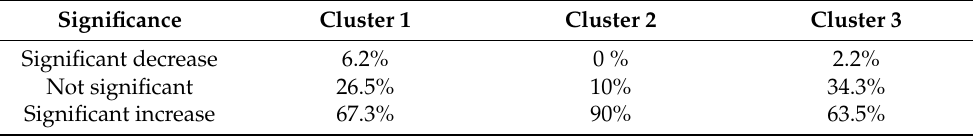
Table 4. Percentages of Mann–Kendall results for each cluster based on URF with